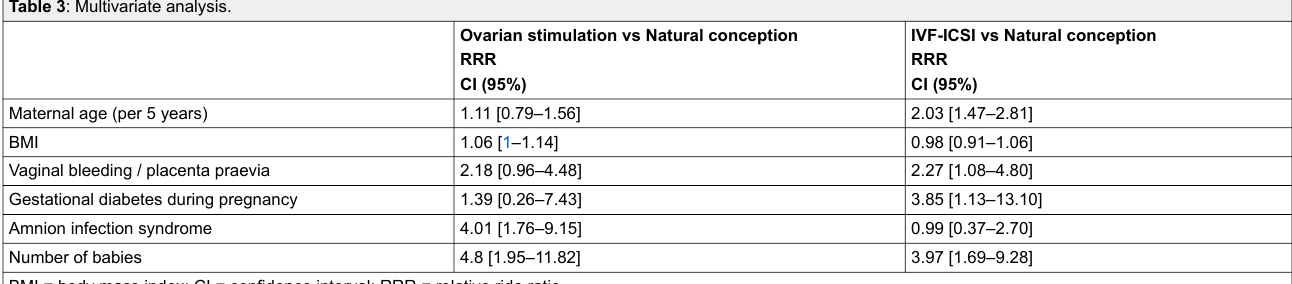
Ovarian stimulation vs Natural conception RRR CI (95%)